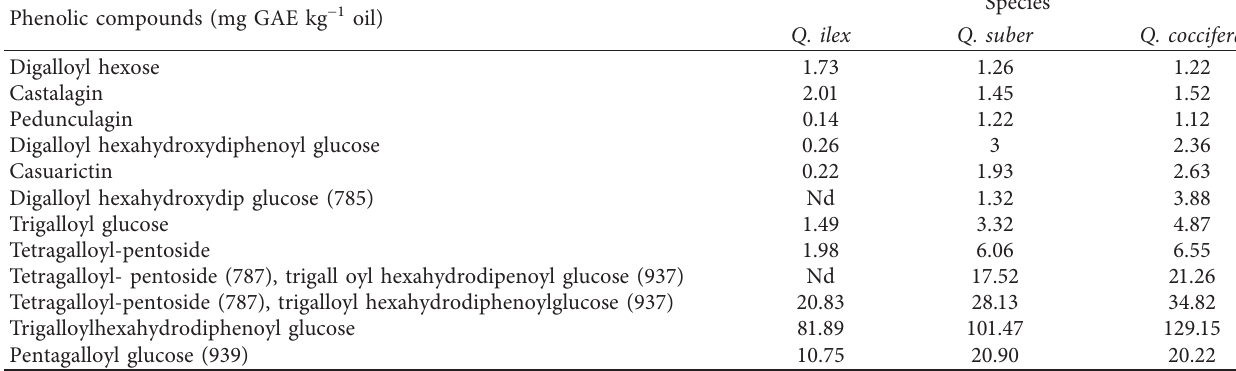
Table 5: Polyphenols of acorn oil.